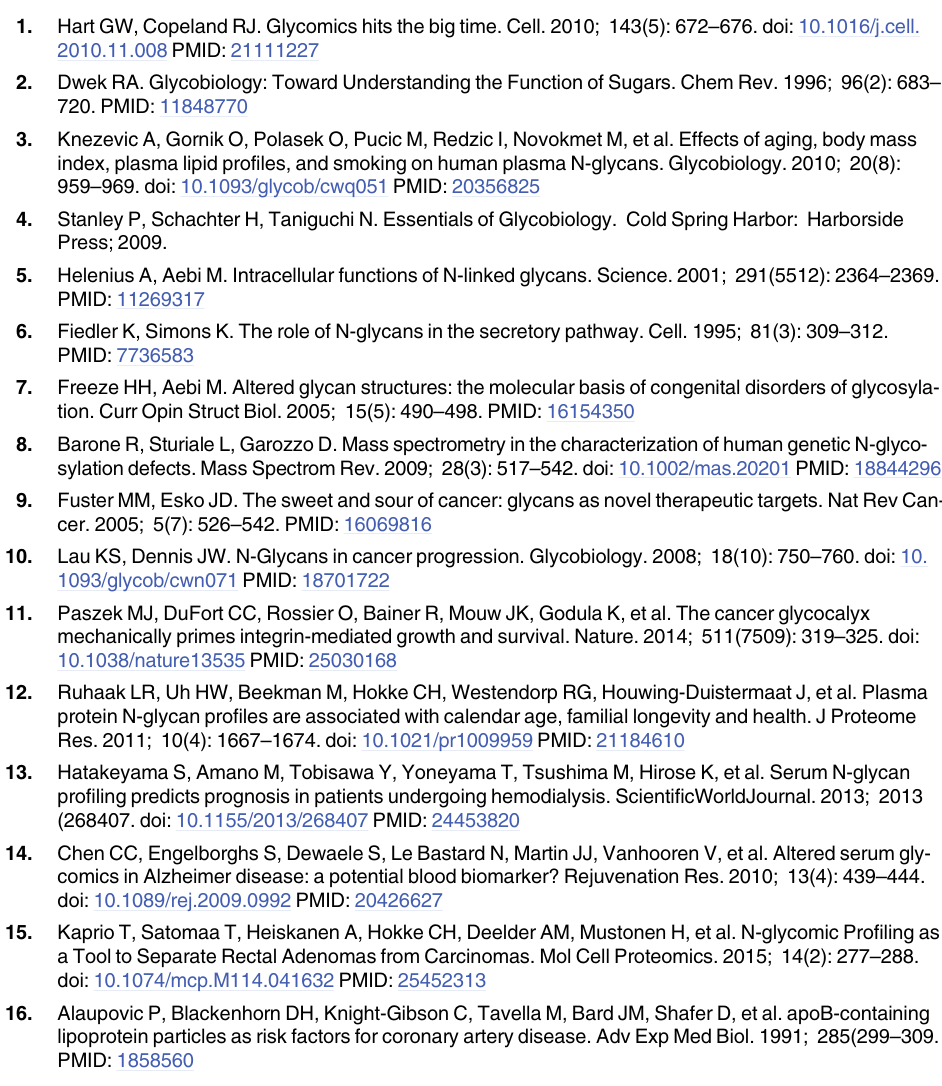
S4 Fig. The plasma N-glycan profiling from controls and hypercholesterolemic rabbits. N- glycan levels of two groups were indicated by a heat map ( A ). The intensity of red color repre- sents higher levels of N-glycans while blue color represents lower levels of N-glycans. Peak intensity ratio of N-glycans to β -cyclodextrin was used to calculate high-mannose (B), complex (sialylated) (C) and complex (undercorated) (D) from control and hypercholesterolemic group. Data are expressed as the mean ± SEM. n = 5 for each group. (cid:4) P < 0.05, (cid:4)(cid:4) P < 0.01 vs. control. HCD, high cholesterol diet; und, undercorated; sia, sialylated.